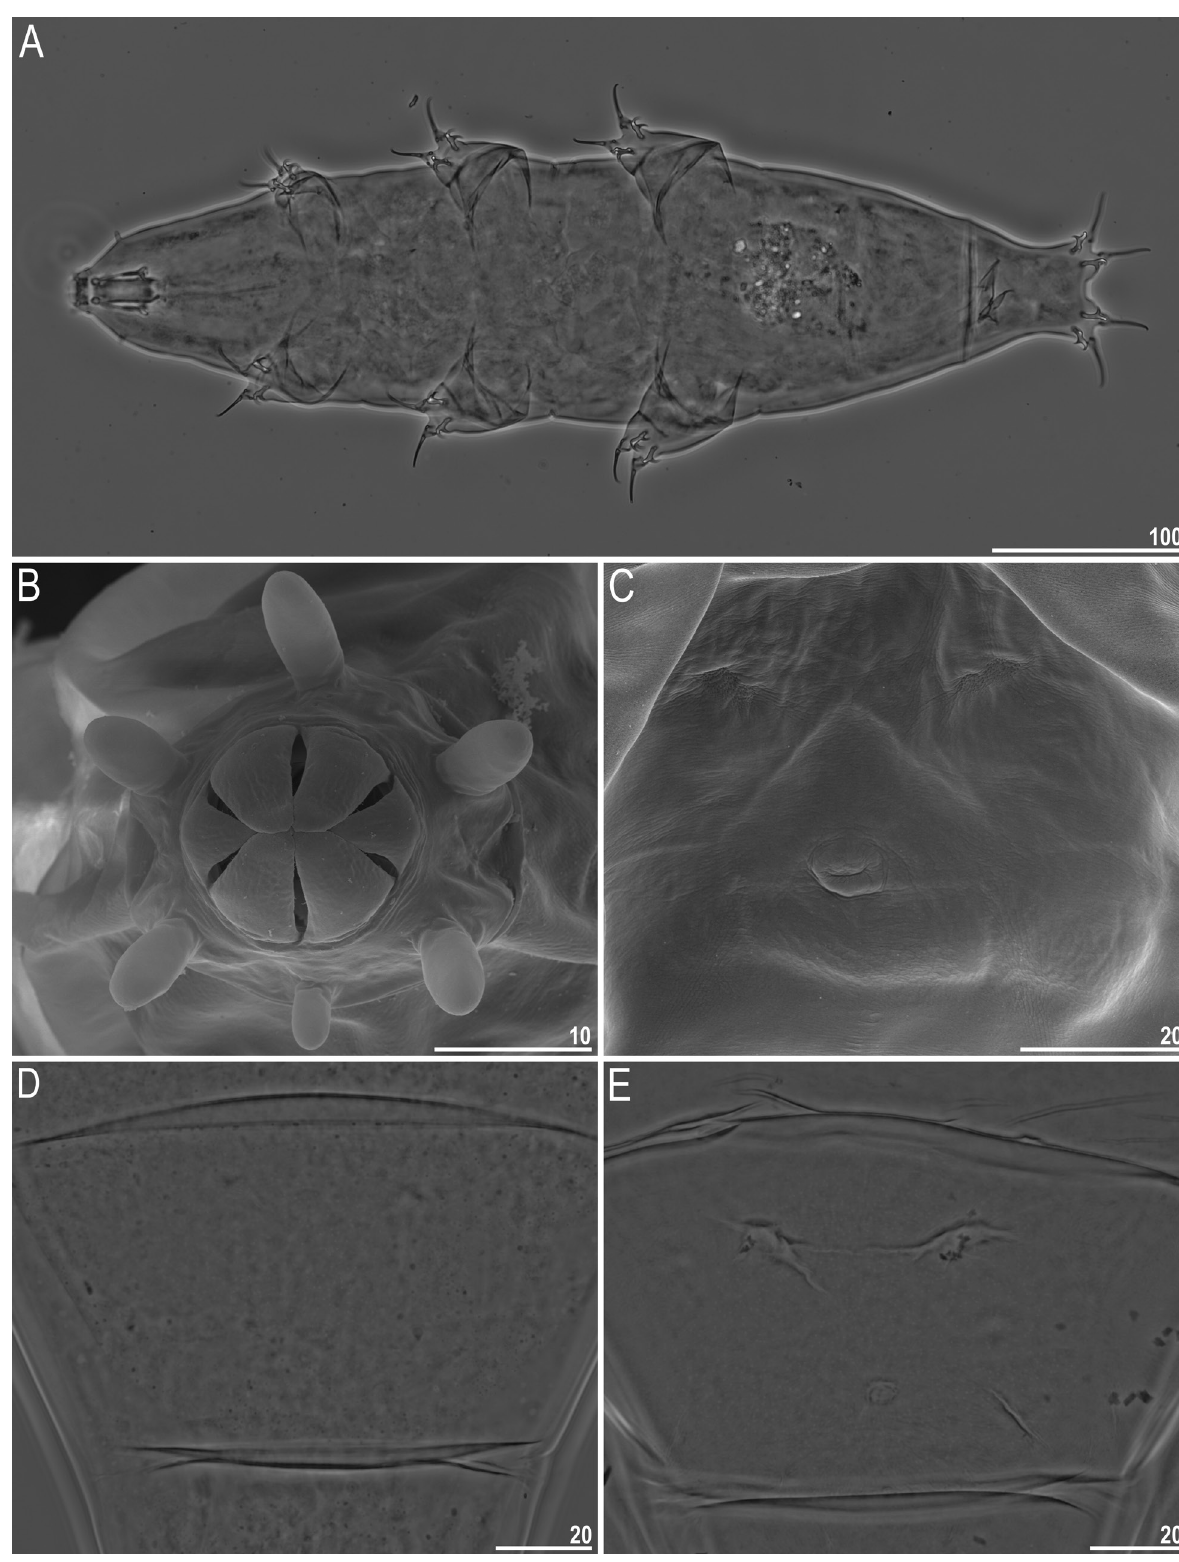
Figure 4. The morphology of Milnesium reductum Tumanov, 2006 A Habitus of adult female, PCM; B SEM photograph of mouth opening; with six, unequal in size peribuccal lamellae, so-called 4+2 configuration; C SEM photograph of smooth dorsal cuticle with visible single, complex pseudoplate; D smooth dorsal cuticle, with visible single pseudoplate and faint pseudopores, spec - imen from KG.013 population, PCM; E smooth dorsal cuticle, with visible single pseudoplate and faint pseudopores, paratype, PCM. All the scale bars are given in